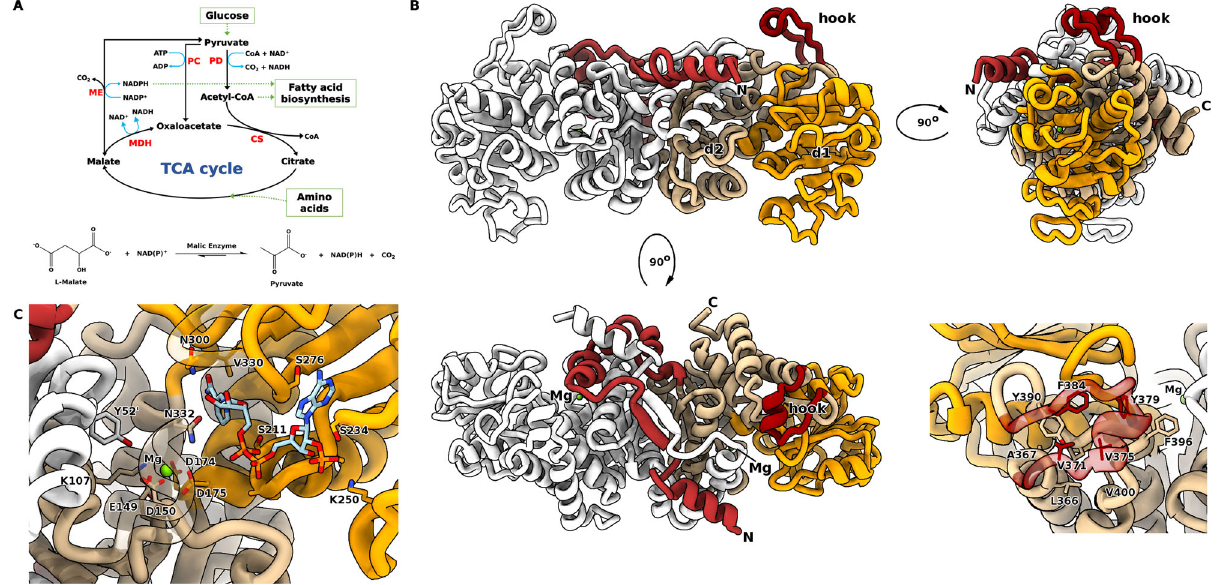
Fig. 1 Function and structural features of the malic enzyme domain. A Overview of MaeB malic enzyme (ME) metabolic context, with malate dehydrogenase (MDH), pyruvate carboxylase (PC), pyruvate dehydrogenase (PD) and citrate synthase (CS); reaction outlined beneath. The ME:MDH:PC cycle is capable of acting as a transhydrogenase. B Structure of the MaeB ME domain dimer, shown from three orthogonal views, with crossover (red – brown), d1 (orange), d2 (beige) and hook (red) subdomains. Lower righthand panel illustrates hydrophobic packing between the hook and the d1:d2 interface. C Interactions observed in the MaeB ME :NADP + complex, relevant residues in contact with NADP + (light blue) are shown in stick form. The loop over the Mg ion is rendered transparent for clarity; the crossover region donates Y52 (labelled with a prime) to the opposing active